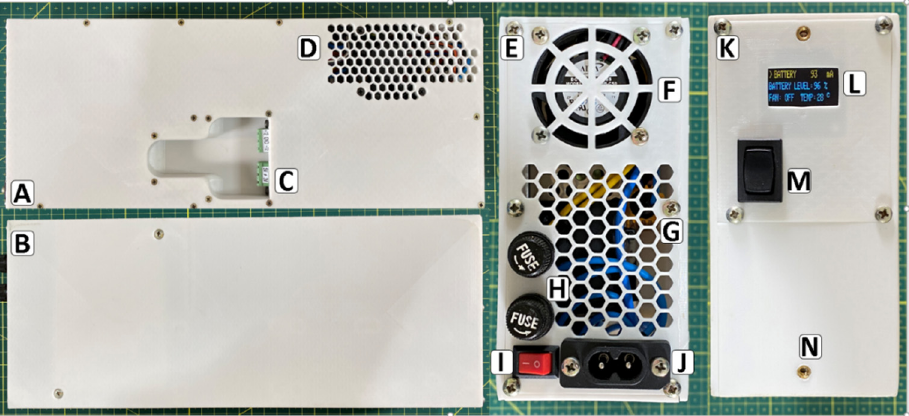
Figure 10. The assembled power supply: A—Left side of the power supply, B—Right side of the power supply, C—Power Connection area, D—Ventilation area, E—Back side of the power supply, F—Cooler, G—Ventilation area, H—Fuse holders, I—ON/OFF switch, J—AC input connector, K—Front side, L—OLED display, M—Logic switch, N—Attachment holes.